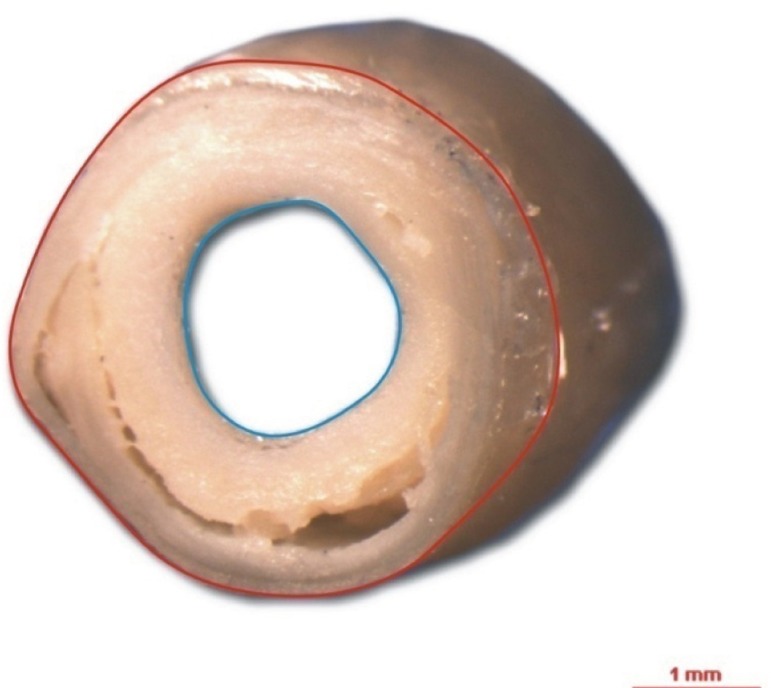
Cross-sectional image of basilar artery from the circle of Willis.
The red tracer is placed on the outer circumference of the artery
and the blue inner tracer on the circumference of the lumen.
Calibration bar=1 mm.